Question: What does this figure show? Answer in one sentence.
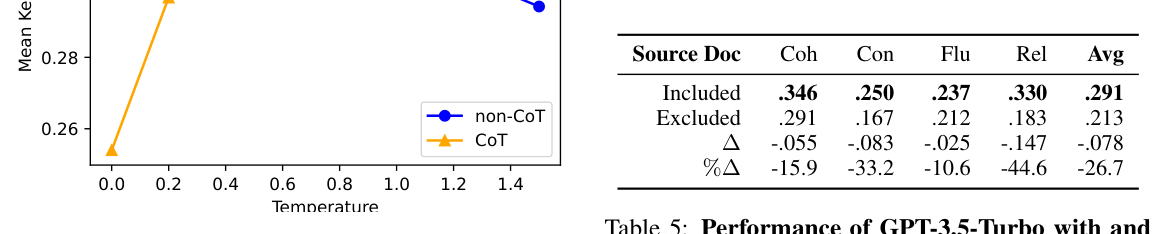
Answer: Performance of CoT and non-CoT prompt- ing at varying Temperatures. Each prediction is com- puted by the average of 10 generations. Low temper- atures are beneficial when making simple predictions, but higher temperatures (to a point) help improve perfor- mance when using Chain-of-Thought (CoT) prompting. This could be because of a more diverse set of explana- tions, leading to more unique features for prediction.